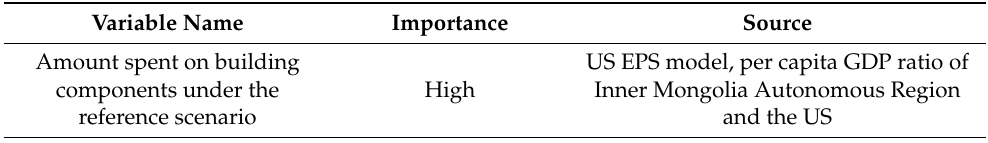
Table 2. EPS Model Data and Sources in Inner